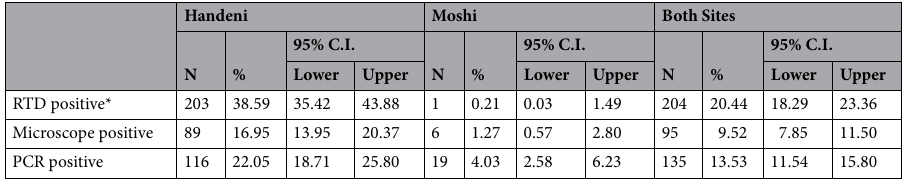
Table 1. Malaria prevalence in the Handeni and Moshi district. *HRP2 only or both HRP2 and LDH.